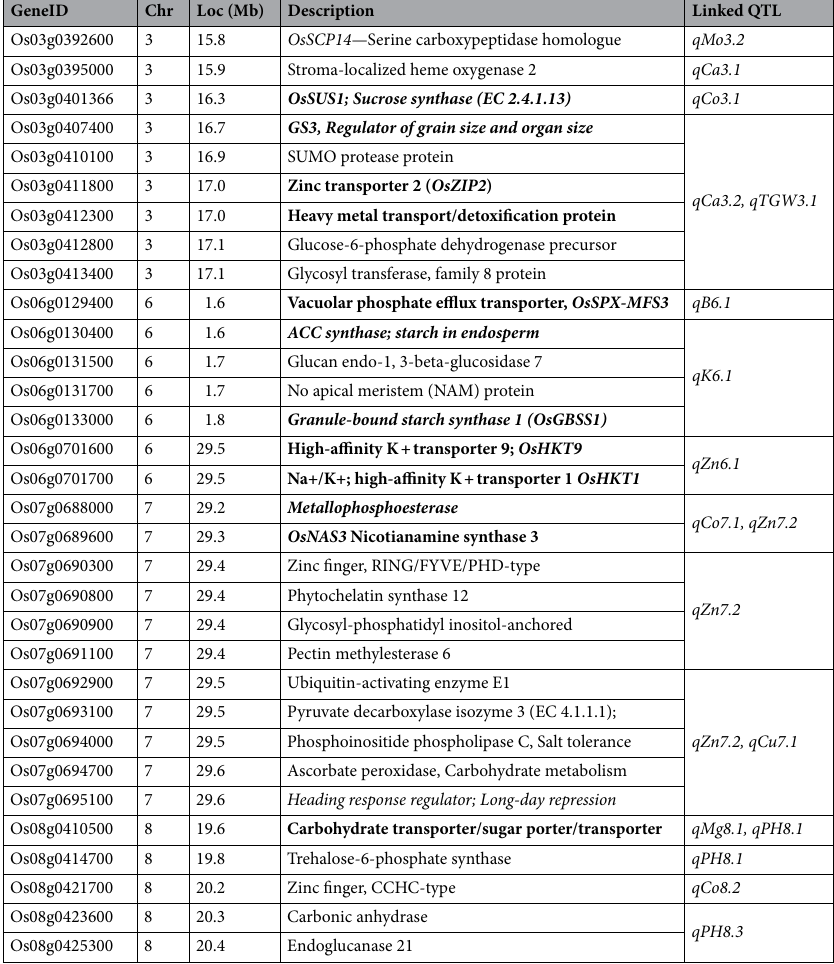
Table 4. Genes included in the localized region delimited by the most significantly associated SNPs with element concentrations. Genes involved in metal transporting are coded in bold, flowering in italics, starch synthesis/grain size in bolditalics. Gene annotation information is from https:// rapdb. dna. affrc. go. jp/ downl oad/ irgsp1.